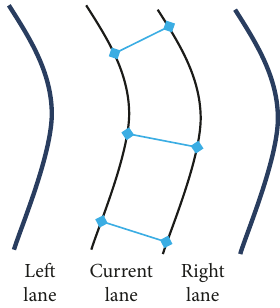
Figure 1: Sampling lane width of the current